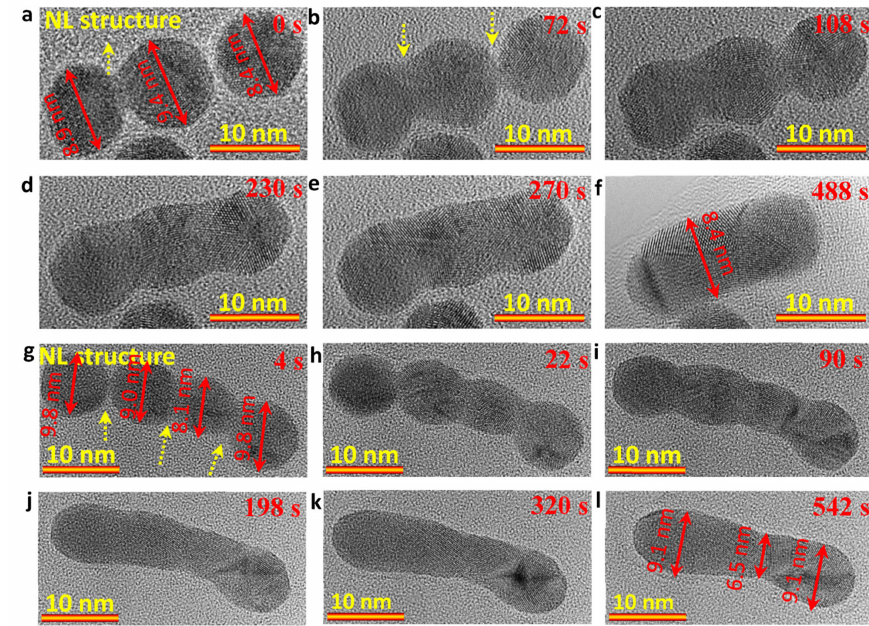
Figure 5. ( a – f ) Sequential TEM images from Video S2 showing the growth of Au NRs with a length of ~19 nm through the attachment of three Au NPs in a tip-to-tip way; ( g – l ) Sequential TEM images from Video S3 showing the growth of Au NRs with a length of ~32.5 nm through the attachment of four Au NPs in a tip-to-tip way. The electron dose rate is ~1.0 × 10 5 e/Å 2 s. To shed further light on the structural evolution and to quantify the growth dynamics of the Au NRs with different lengths in Videos S1–S3, the change of length (l), diameter (d) and length–diameter ratio (l/d) with time were investigated by statistical analyses. It is worth noting that the diameter d is an average value here. The results show that the length of the NPs is reduced with time (Figure 6a–c), and the diameter is related to the size of spherical Au NPs and time (Figure 6d–f). At the initial stage, the values of length and averaged width fluctuated rapidly, which can be attributed to the formation and growth of NL structures. The aspect (length/diameter) ratios (Figure 6g–i) indicate that the length of the Au NR formed via particle attachment is mainly determined by the number of tip-to-tip Au NPs, and the aspect (length/diameter) ratio can be modified by regulating the attachment